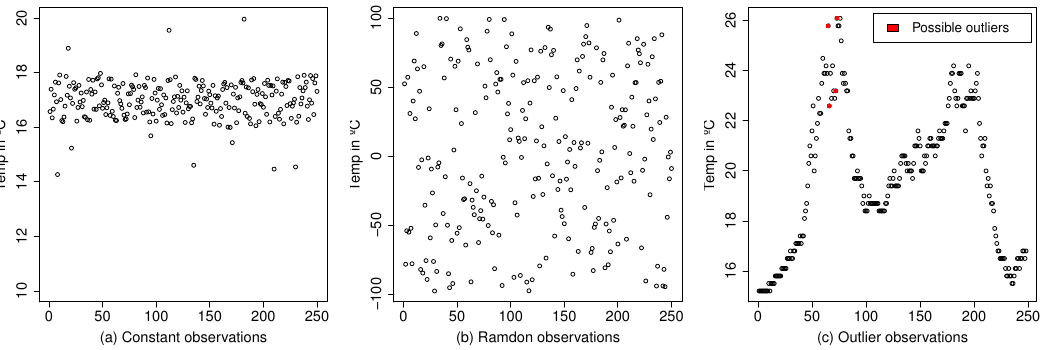
Figure 3. Example of three types of errors. Please note that the y -axis is not on the same